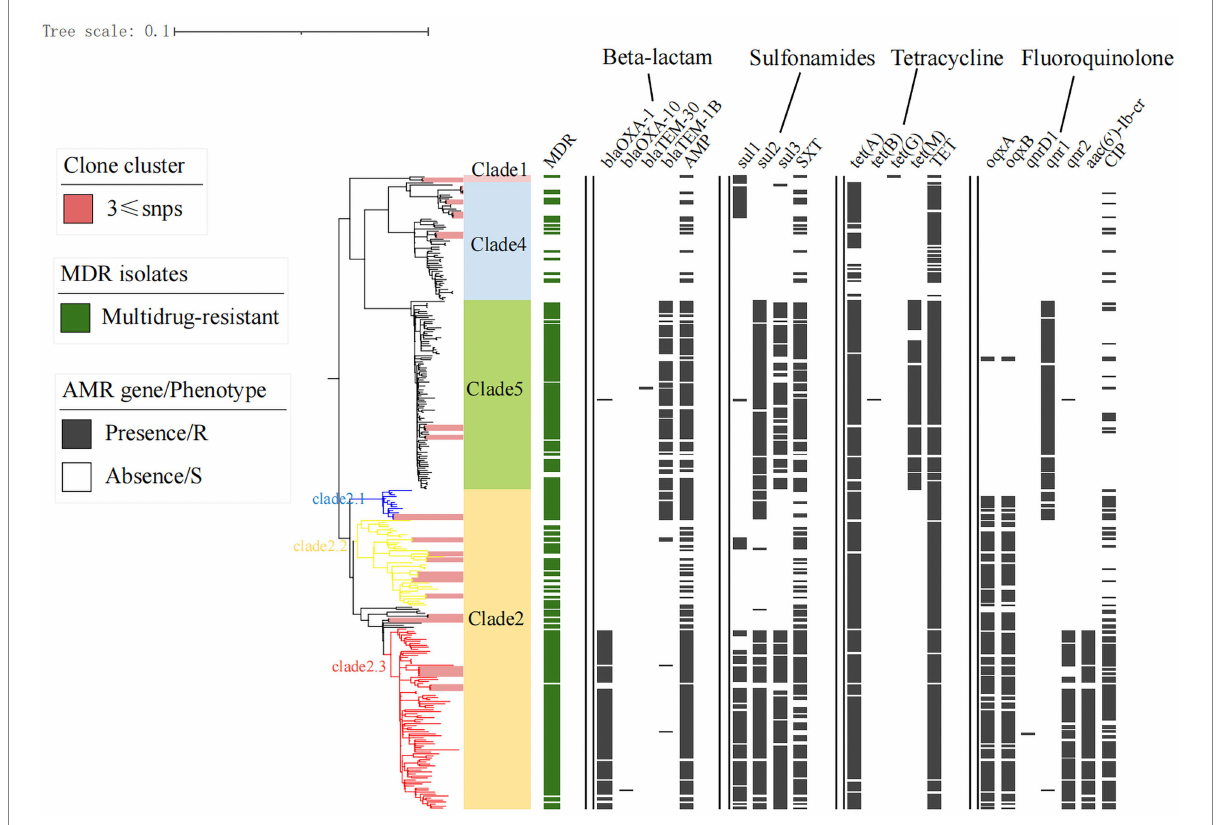
FIGURE 3 Antimicrobial resistance and gene distribution of Shenzhen strains. The maximum likelihood tree of 314 Shenzhen isolates is shown on the left, with the evolutionary branch of ST40 S . Derby in background color (as in Figure 1); on the right, the distribution of multidrug-resistant (MDR) isolates (green bars), representative isolates for phenotypic testing, and the presence (black bars) or absence (white bars) of antimicrobial resistance-associated mutations and genes.